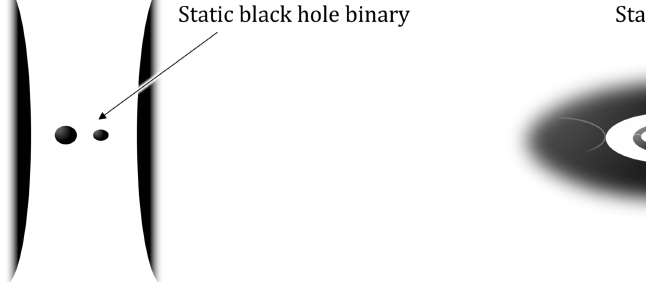
Figure 2 . Static black hole binaries and black rings obtained by placing them inside expanding bubbles of nothing, which surround them with acceleration horizons. The binary need not be symmetrical. These configurations can be regarded as limits of double nested static binaries (four black holes along a line), and of two coaxial black